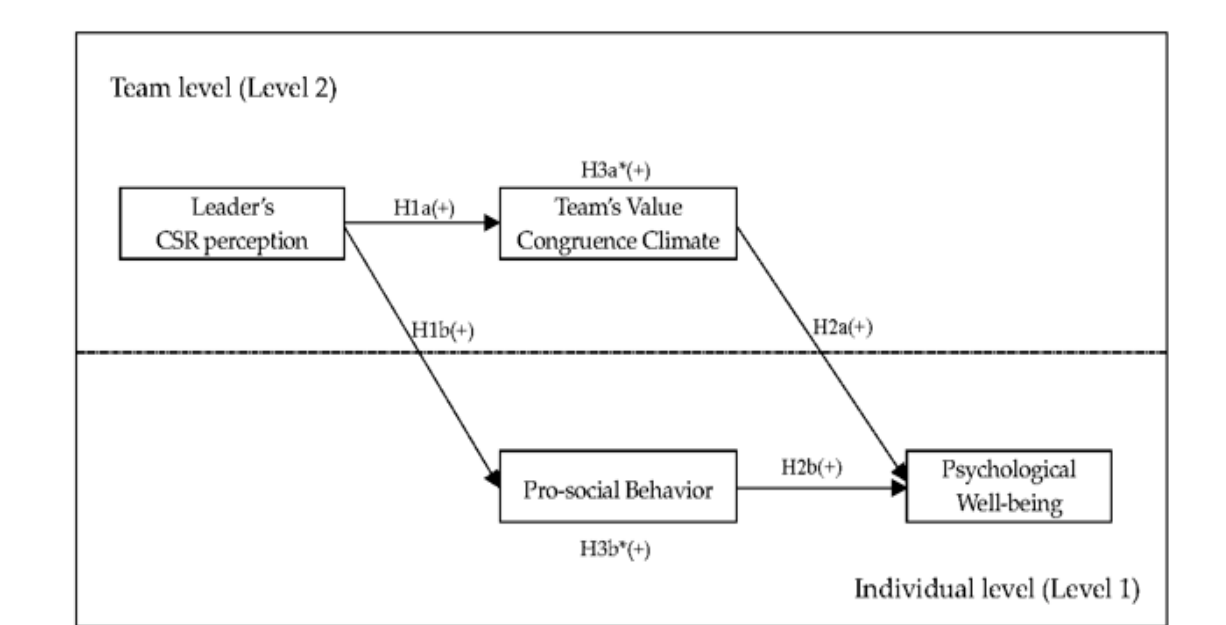
Figure 1. Study model. *Mediation effect; CSR = Corporate Social Responsibility; (+) = Positive relationship between variables.